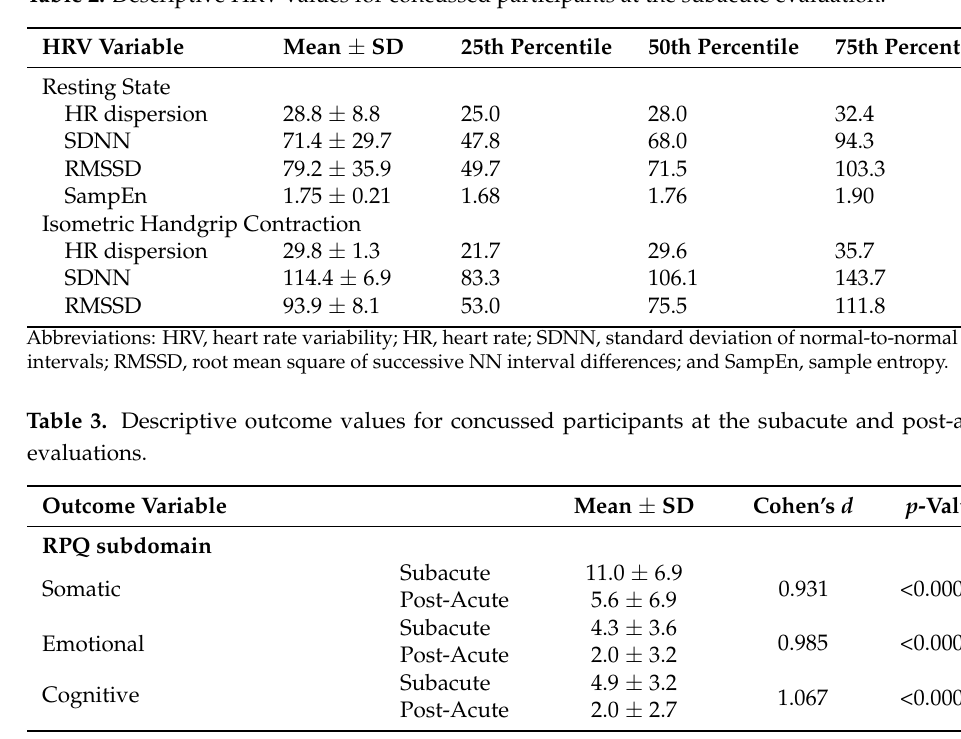
Table 2. Descriptive HRV values for concussed participants at the subacute evaluation.